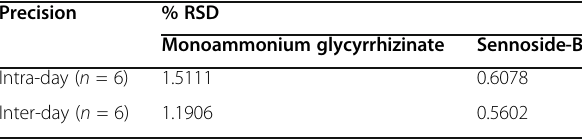
Table 5 Linearity data of phytomarkers and their R 2 value Sr. No.